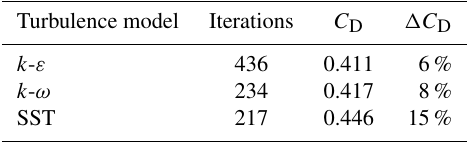
Table 1. Drag comparison of three turbulence models with an inlet velocity of 22.2ms − 1 . The drag coefficient ( C D ) for each turbu- lence model is reported with the number of iterations required to achieve a solution and the percent difference ( (cid:49)C D ) from the man- ufacturer’s reported value ( C D ) of the vehicle